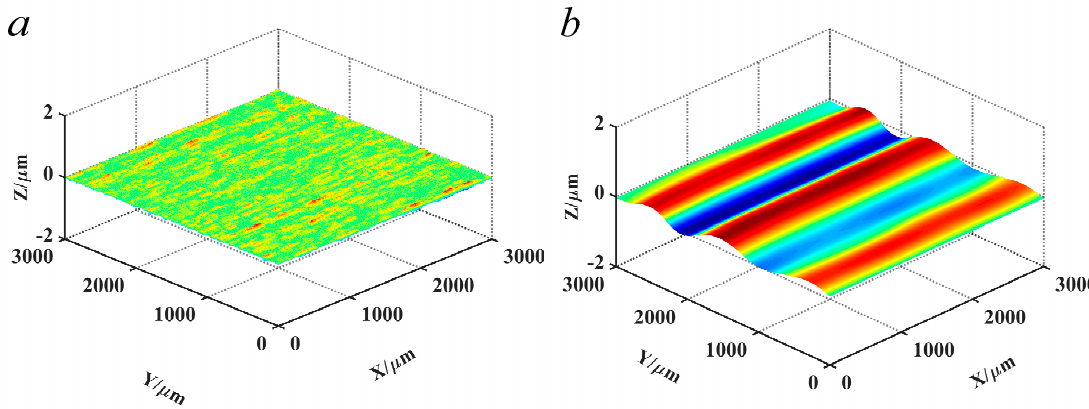
Figure 6. Digital combination model. ( a ) Reconstructed topographies of the HFB; ( b ) reconstructed topographies of LFB.